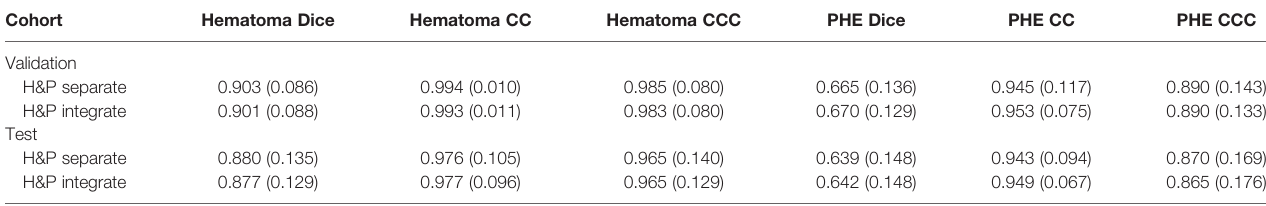
TABLE 1 | Lesion Segmentation Performance on Validation and Test Datasets.